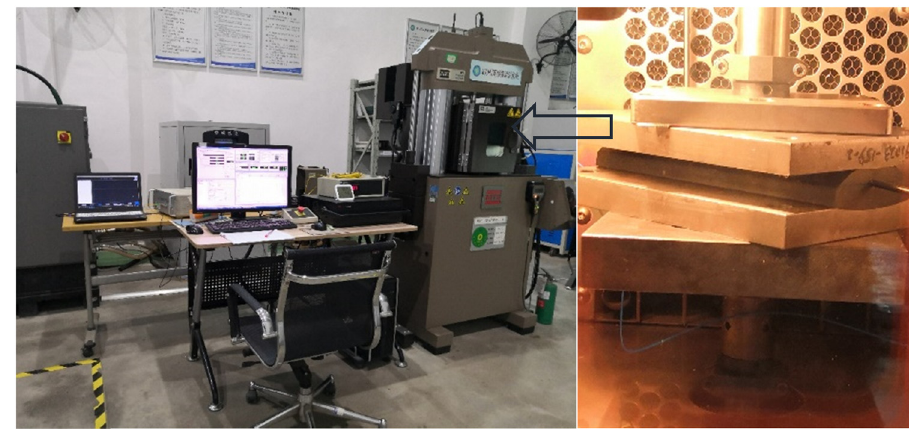
Figure 11: Load condition monitoring test for the rubber